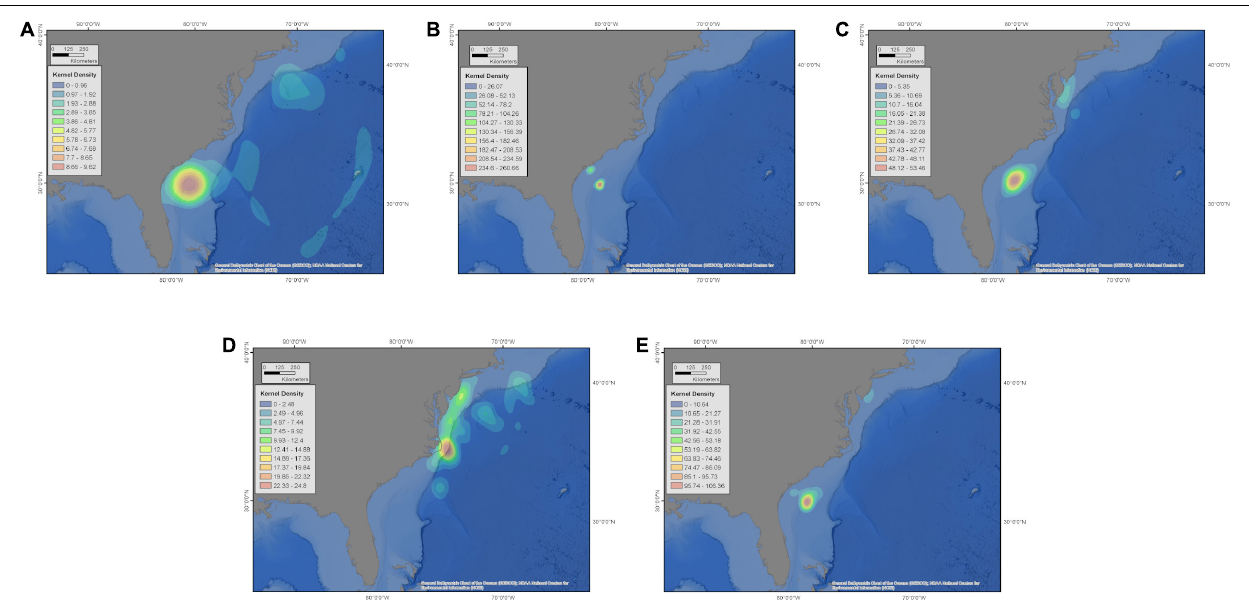
FIGURE 11 | Kernel density distributions of daily locations between October 16 and June 30 for a 4.9 m TL female white shark (WS12-17) for year 1 ( A: 2012–2013), year 2 ( B: 2013–2014), year 3 ( C: 2014–2015), year 4 ( D: 2015–2016), year 5 ( E: 2016–2017). This shark showed strong fidelity to an area on the shelf off the coast of Georgia in 4 of 5 years